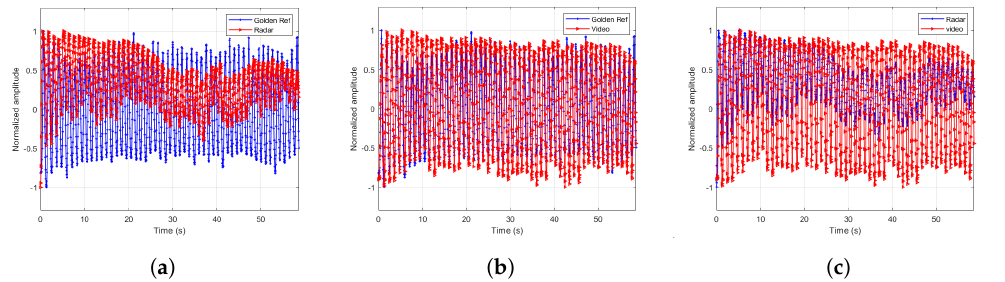
Figure 10. Extracted signals comparisons for breathing rate 56.25 BPM. ( a ) Radar and ground truth signals. ( b ) RGB and ground truth signals. ( c ) Radar and RGB